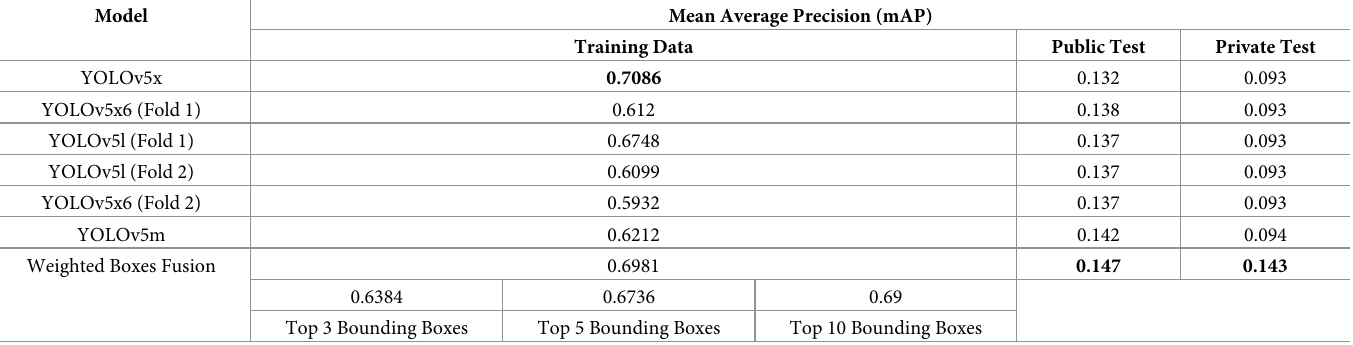
Table 6. Mean average precision for the training dataset.